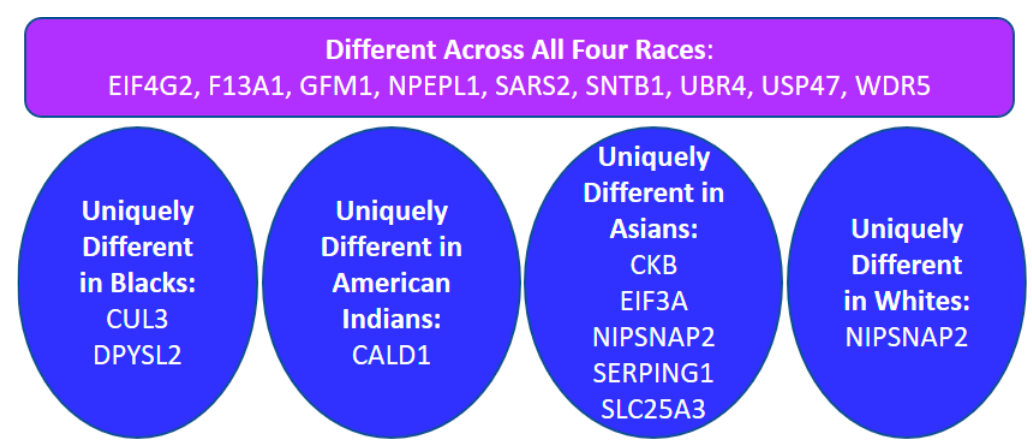
Figure 2. Comparison of protein differences across all racial groups. Table 2. List of gene IDs for proteins significantly different in endometrial cancer specimens from Black, American Indian and Asian racial groups compared to the White racial group.